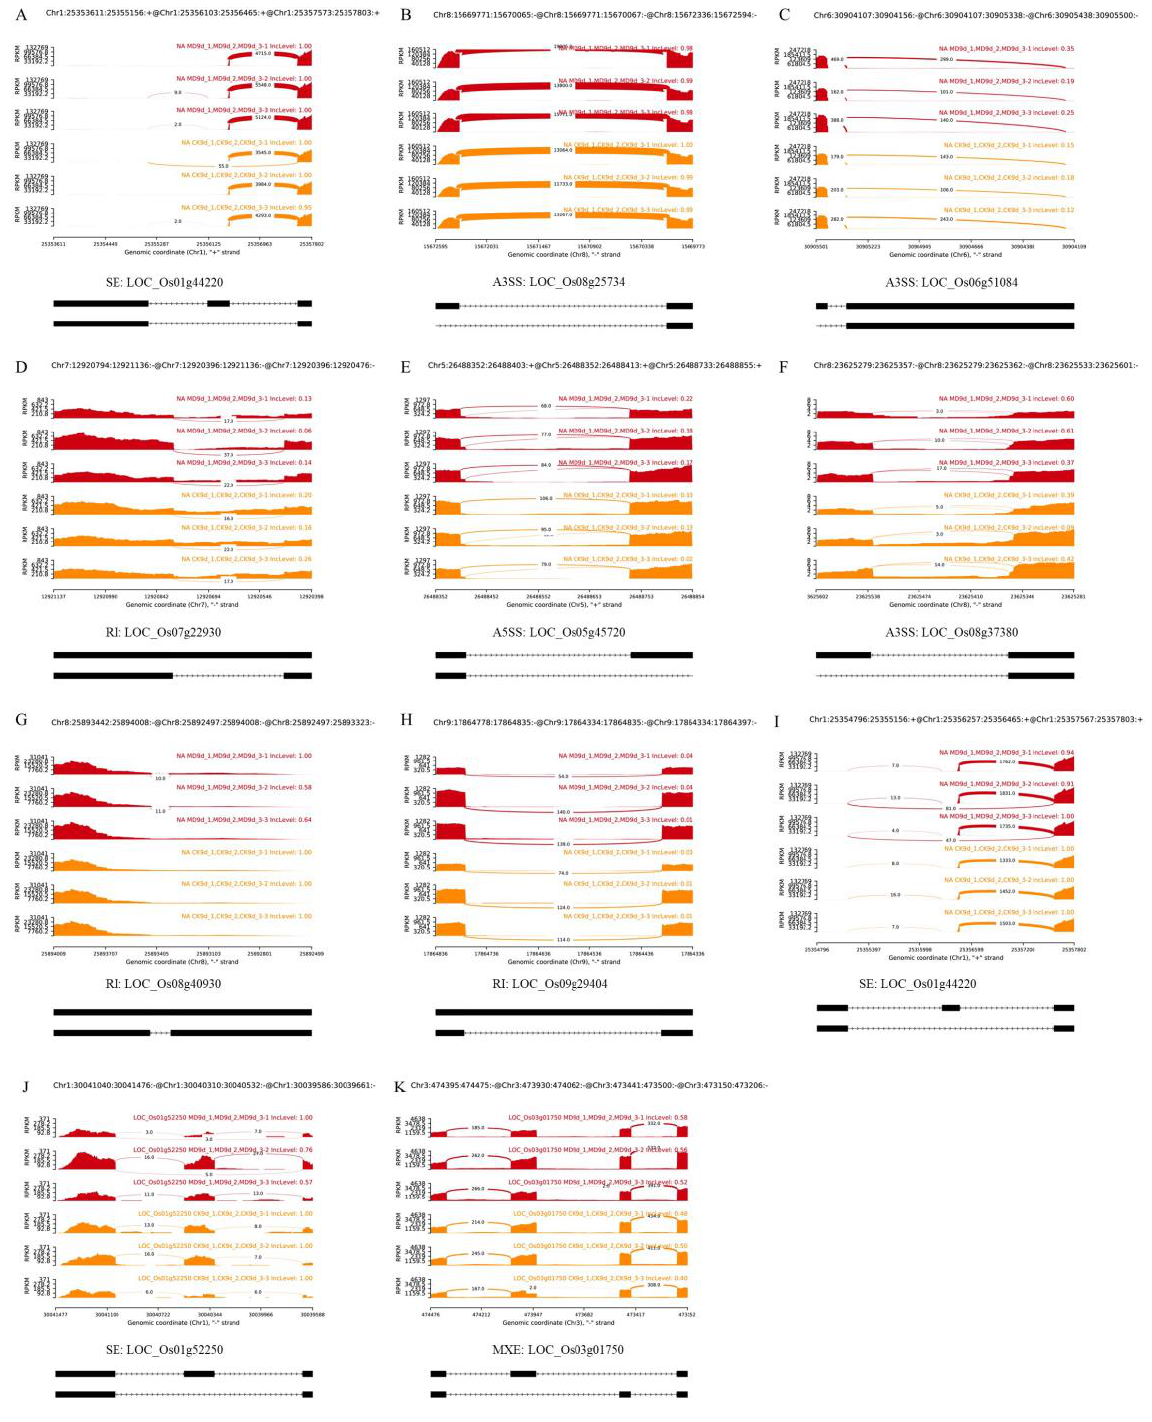
Figure 4. Quantitative visualization (Sashimi plot) of some DAS events of starch synthesis-related genes of rice inferior spikelets in the comparison of CK and MD at 9 DAA. Known AS events ( A – H ) and novel AS events ( I – K ) of starch synthesis-related genes in inferior kernels under CK and MD treatments. ( A ) LOC_01g44220; ( B ) LOC_08g25734; ( C ) LOC_06g51084; ( D ) LOC_07g22930; ( E )